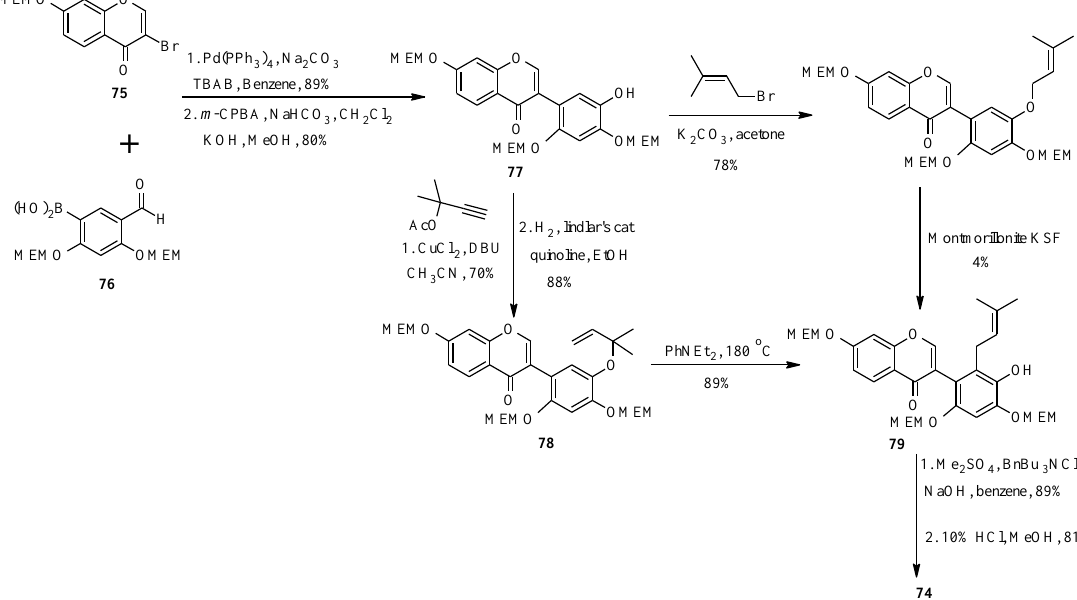
Scheme 23. Total synthesis of kwakhurin ( 74